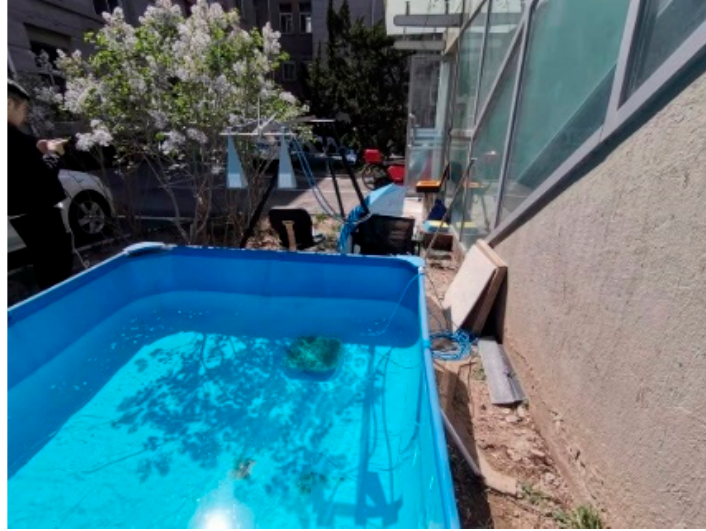
Figure 4. Interference suppression experiment’s platform construction.